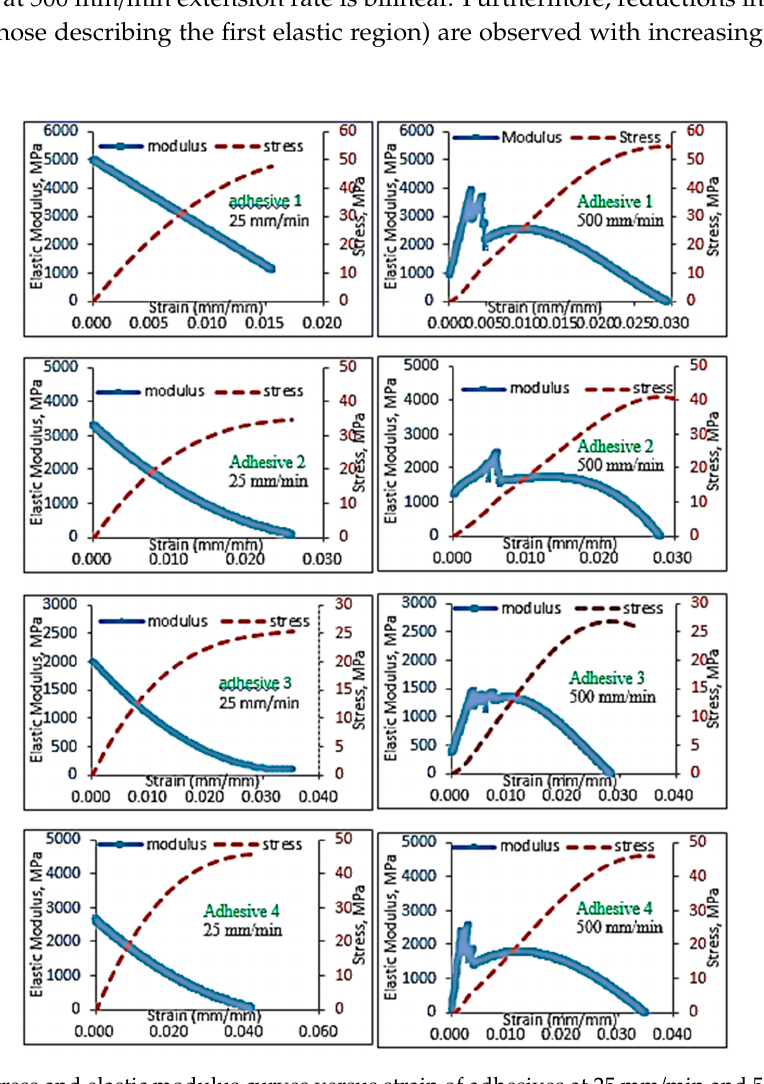
Figure 12. Stress and elastic modulus curves versus strain of adhesives at 25 mm/min and 500 mm/min extension rates.